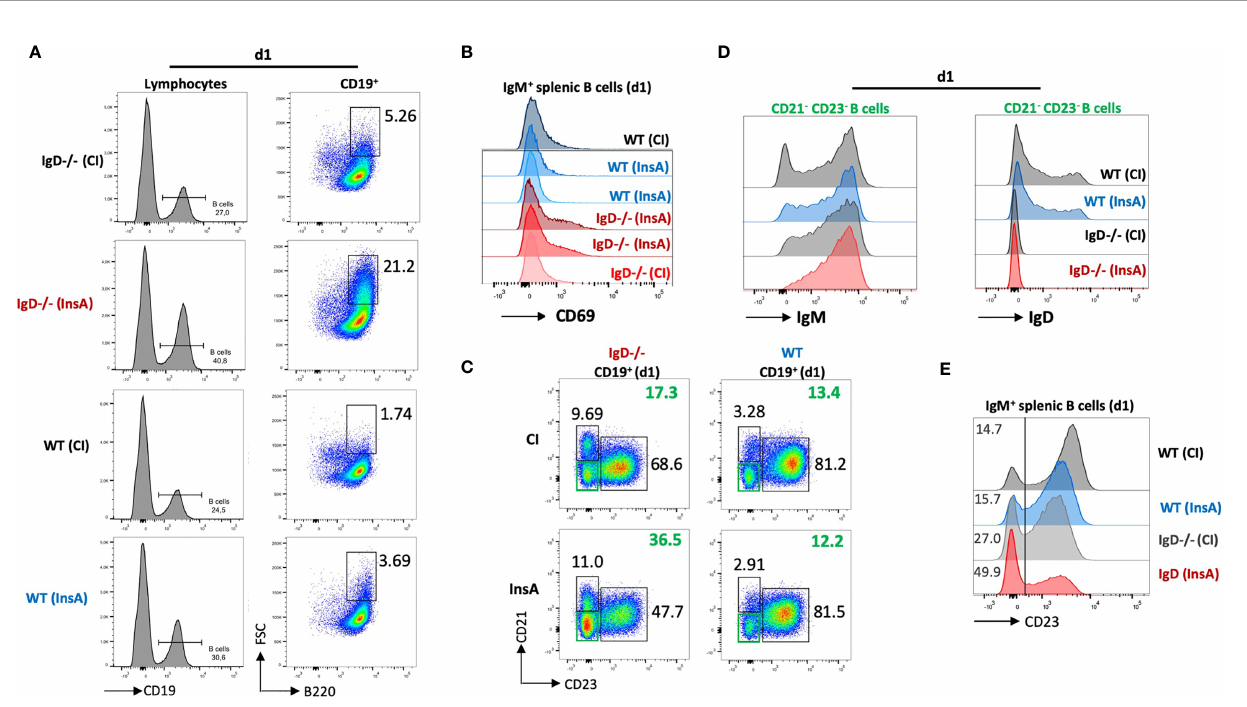
FIGURE 5 | The IgD-class BCR controls a rapidly responding CD21 - CD23 - B cell population that is able to secrete autoantibodies 24 hours after immunization. (A – E) Flow cytometric analysis of IgD-de fi cient (n=4/group) and WT (n=4/group) mice immunized with InsA-KLH + CpG ODN1826 or CpG ODN1826 (CI). All panels show representative plots pre-gated on lymphocytes (FSC/SSC), single cells (SSC-H/SSC-W) and viable cells ( fi xable viability dye, FVD - ). (A) Histogram of CD19 expression used to gate B cells (CD19 + ) within lymphocyte gate (left). Enlarged (activated) IgM + B cells (FSC hi B220 + ) within B cell gate (right). (B) Histogram showing activated B cells by CD69 expression pre-gated on IgM + B cells. (C) Representative plot showing marginal zone B cells (CD21 hi CD23 lo ), follicular B cells (CD21 lo CD23 hi ) and CD21 - CD23 - (double negative) B cell population in InsA and CI immunized IgD-de fi cient or WT mice. (D) Histograms of CD21 - CD23 - B cells IgM expression (left) and IgD expression (right). (E) Histogram showing CD23 expression in IgM + splenic B